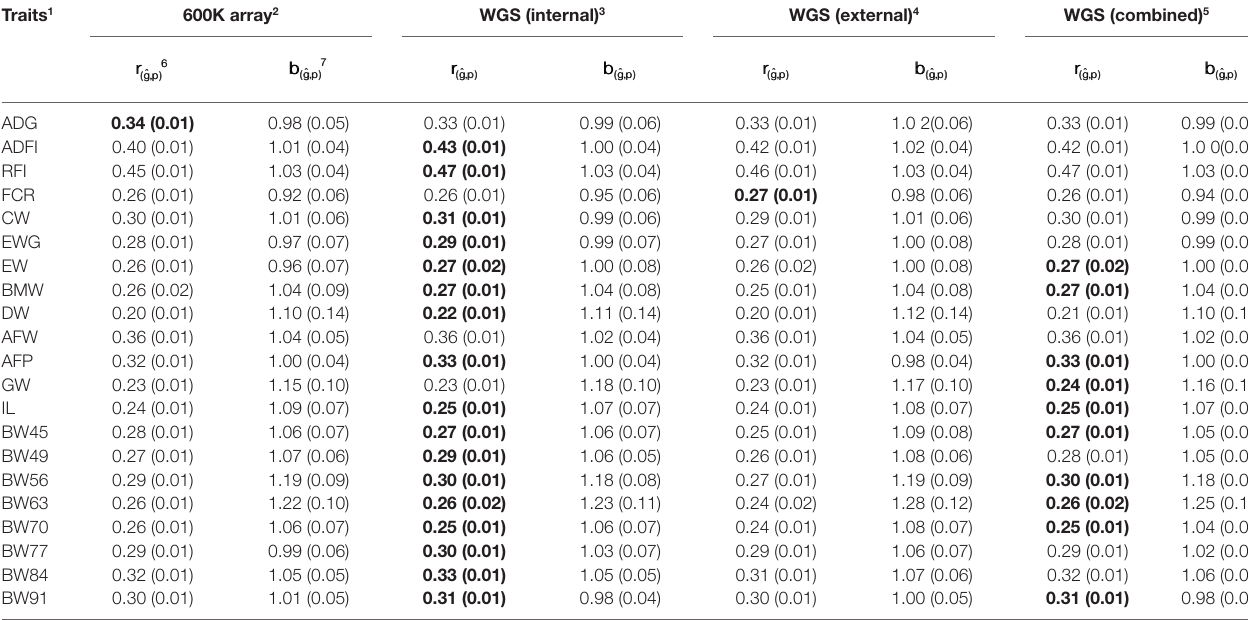
TABLE 1 | Prediction accuracy and regression coefficients of 21 traits in chicken using genomic best linear unbiased prediction (GBLUP) with different genotype data. Traits